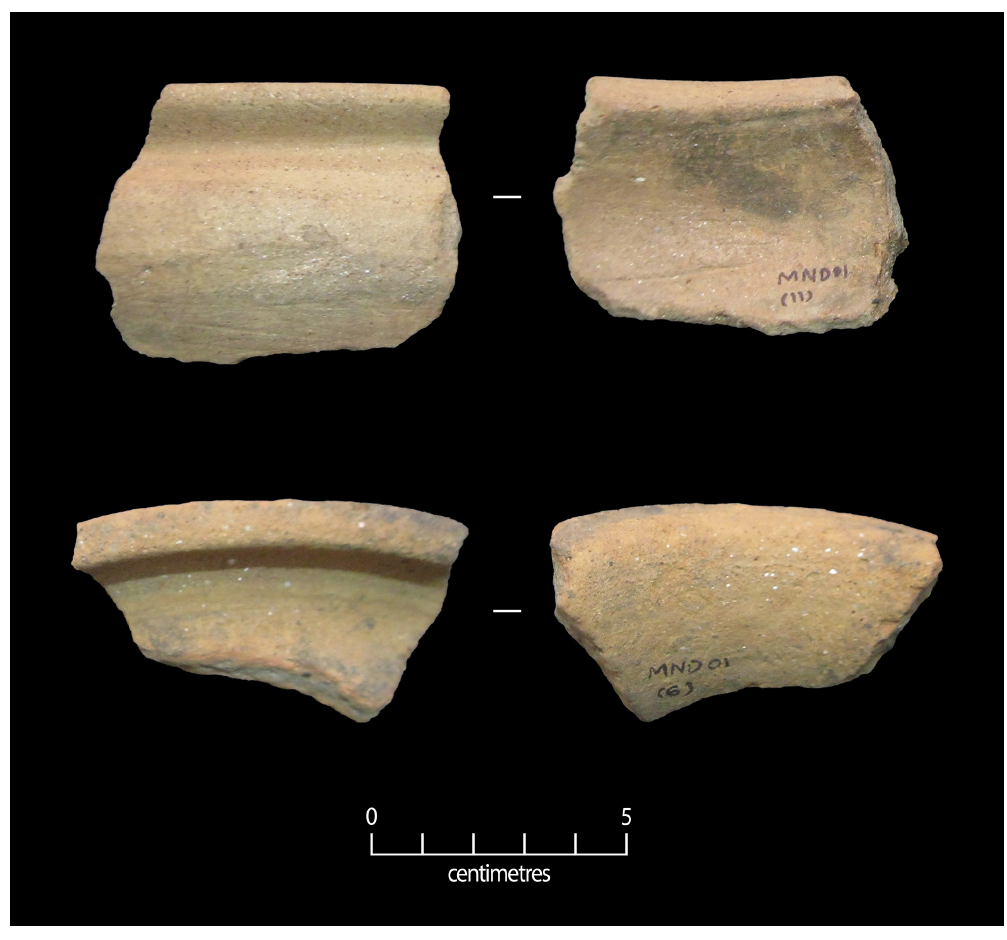
Figure 21: External surfaces of two Class 6 variant 1 potsherds.